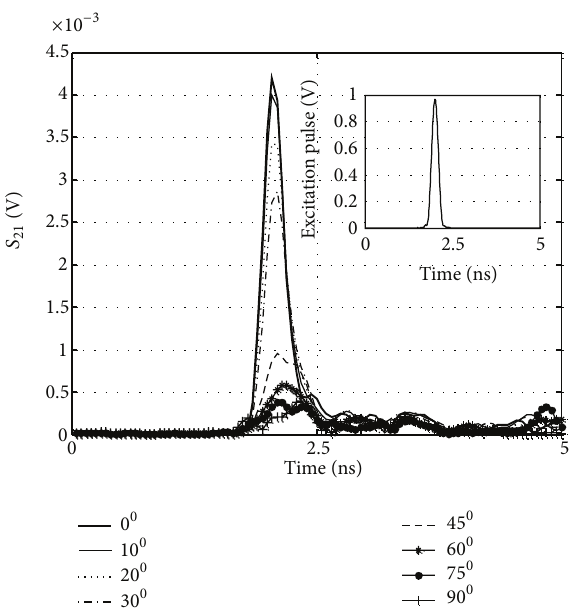
Figure 8: Time-domain characteristic of the proposed antenna measured on received pulse for various angles and for 1.5–11.0GHz. The excitation pulse is given within the figure as